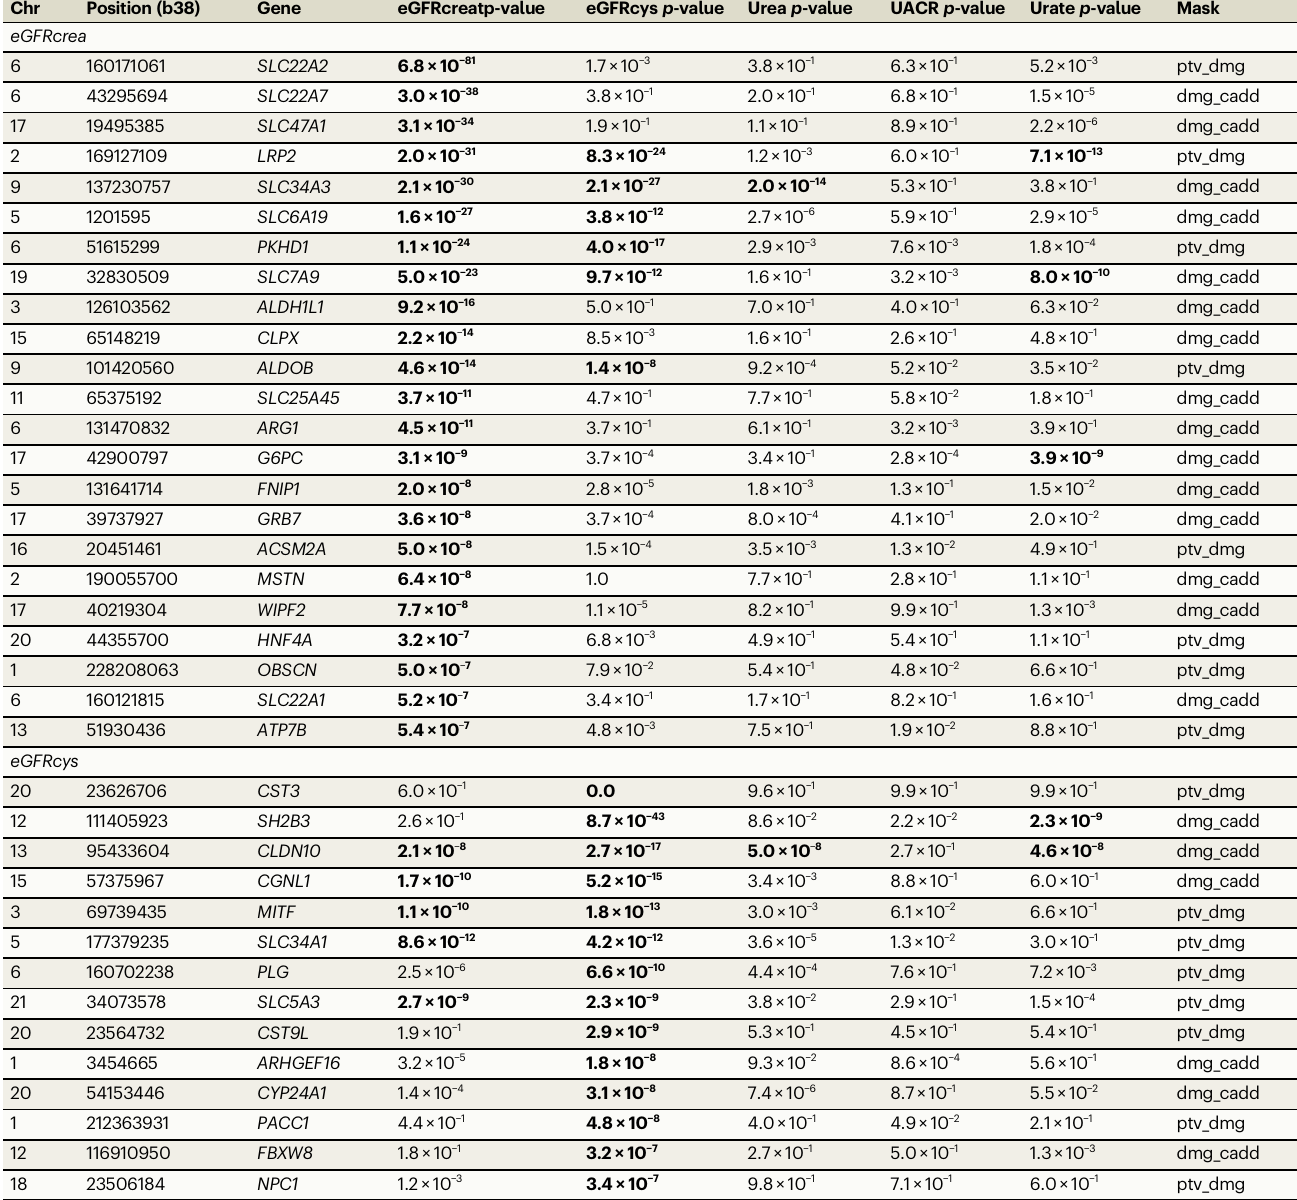
Table 2 | Overview of gene-based test results for eGFRcrea and eGFRcys